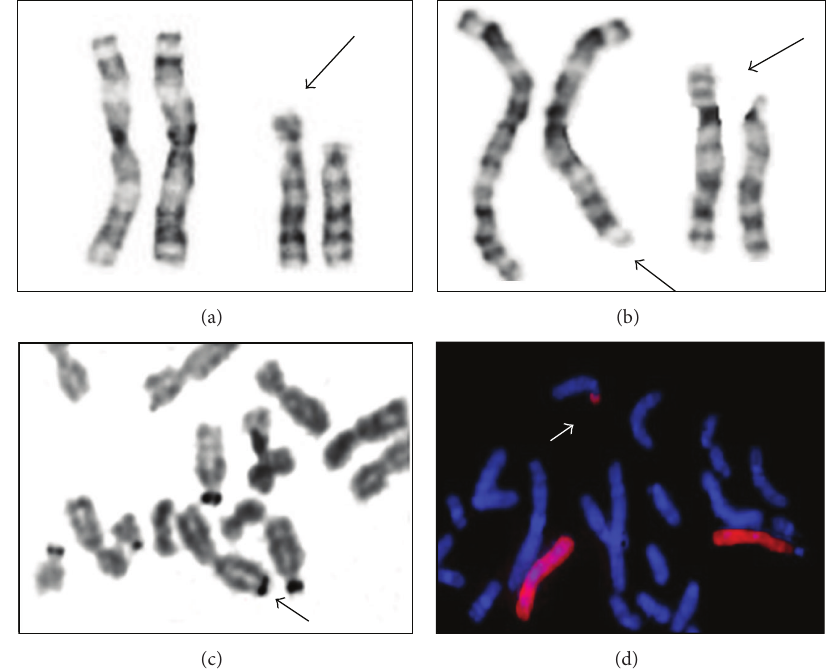
Figure3: Cytogeneticanalysis of blood lymphocytes. (a)Partial karyotype oftheproband, thearrowshowstheadd(13)(q11.1).(b)GTG partial karyotype of individual II.4, the arrows show the t(3;13)(q26.2;p11.2). (c) 3q NOR positive of individual II.4 and acrocentric chromosomal aggregation. (d) FISH with WCP probe for chromosome 3 of individual II.4, arrows show